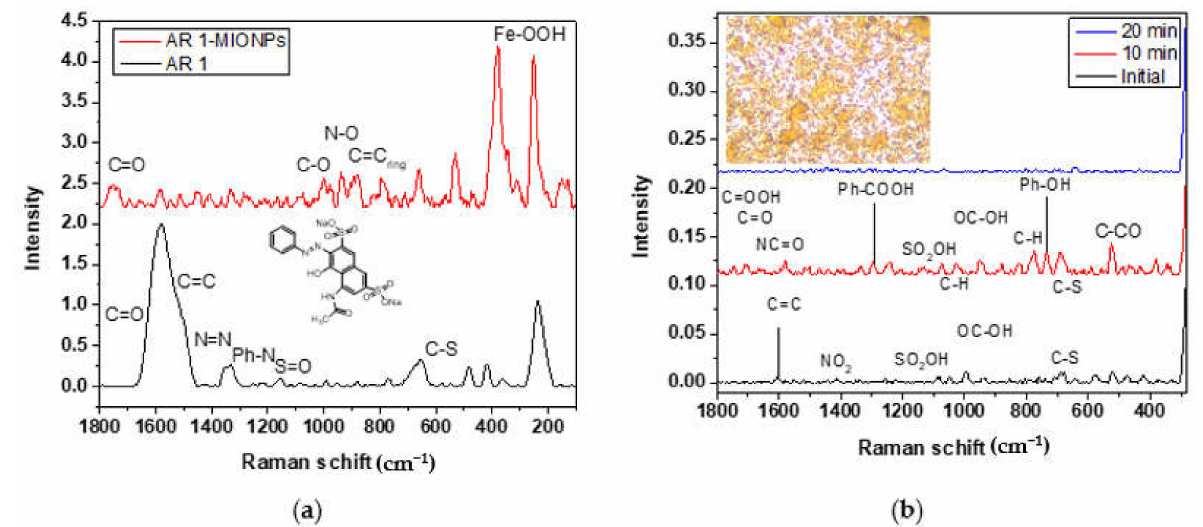
Figure 8. Raman spectra of ( a ) AR 1 (down) and AR 1 adsorbed on MIONPs (up); ( b ) intermediaries’ compounds, and optical image at 50 × magnification of the SERS substrate